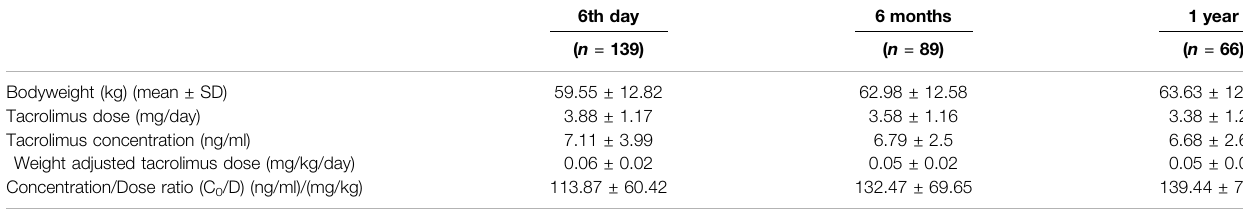
TABLE 2 | Tacrolimus dosing in the study population at 3 time points.